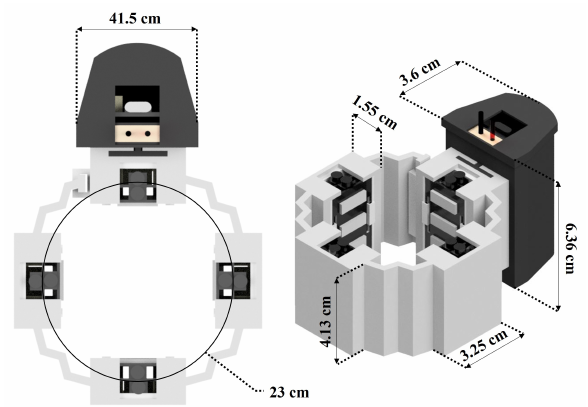
Figure 2. General dimensions of the armband.